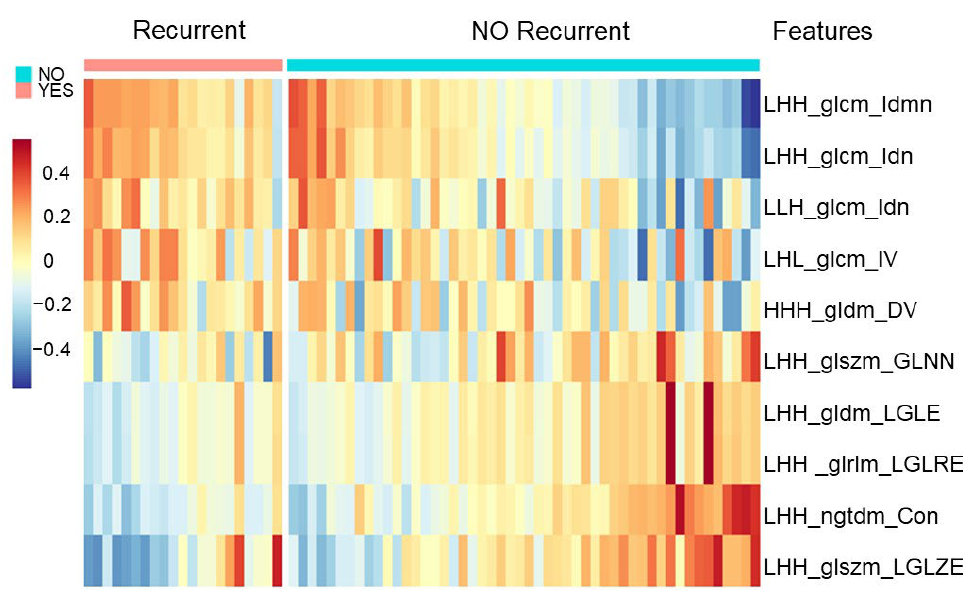
Figure 2. Adjusted radiomic features in the CATCH model. The 10 most significant adjusted radiomic features distinguish the recurrent CRC from the non-recurrent CRC. Positive coefficient values indicate higher significant association between radiomic features and recurrence. A more significant absolute value of the coefficient indicates more profound influence on recurrence.